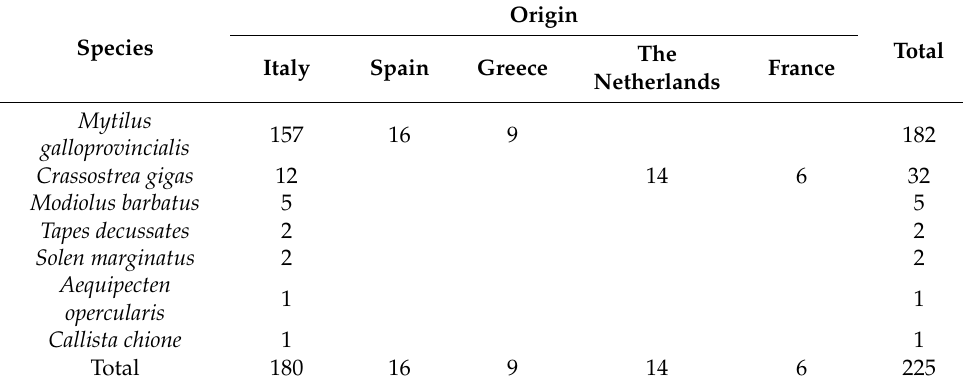
Table 1. Geographic origins of the tested shellfish